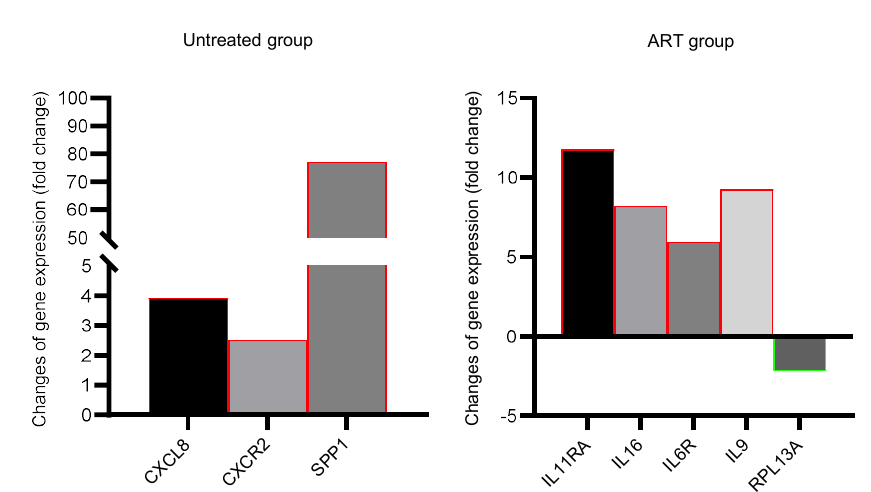
Figure 6. Gene expression changes in the basal ganglia found exclusively in either the Untreated group or the ART group, compared to the healthy control. ( A ) Genes upregulated only in the Un treated group compared to the healthy control group. ( B ) Genes up/downregulated only in the ART group compared to the healthy control group. Red or green borders in the bar graphs represent upregulation or downregulation respectively compared to the control group.